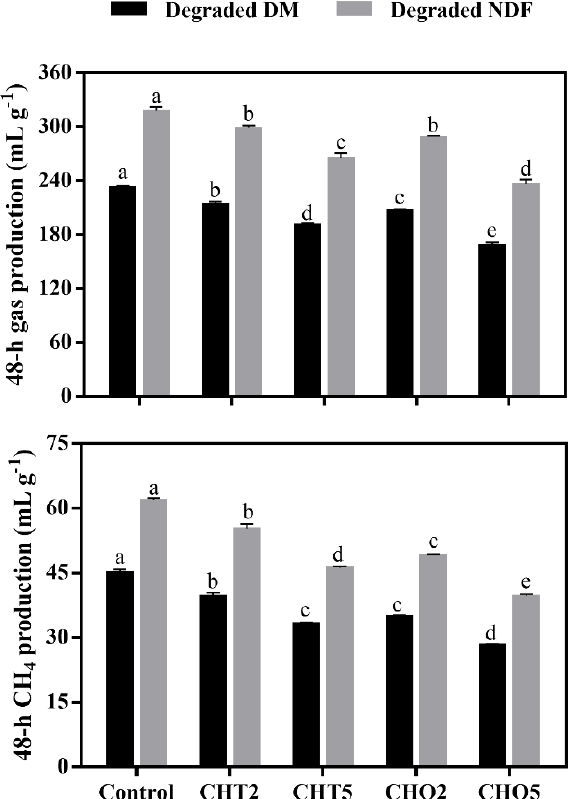
Figure 2. Gas and methane production in the in vitro fermentation cultures receiving untreated or tannin-treated alfalfa silage after 48 h incubation. Control = no tannins; CHT2 = 20 g kg − 1 DM of chestnut tannin; CHT5 = 50 g kg − 1 DM of chestnut tannin; CHQ2 = 10 g kg − 1 DM of chestnut tannin + 10 g kg − 1 DM of quebracho tannin; CHQ5 = 25 g kg − 1 DM of chestnut tannin + 25 g kg − 1 DM of quebracho tannin. Error bars represent the standard error of the means ( n = 3), and different letters (a–e) above the same color column were significant ( p < 0.05).